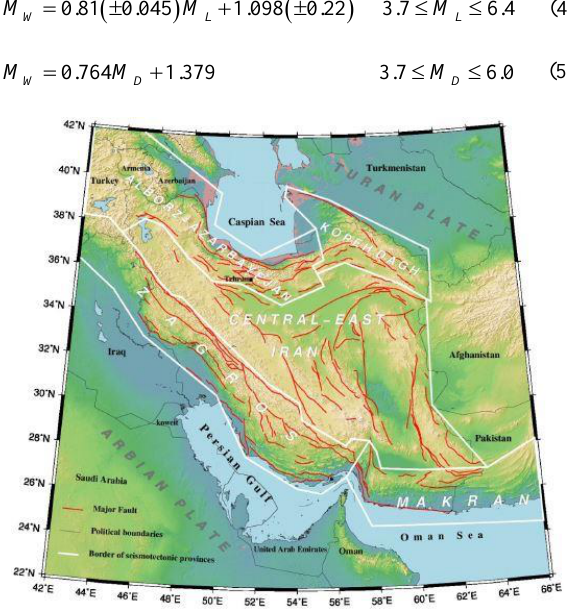
Figure 1. Major tectonic provinces of Iran developed by Mirzaei et al (1998). The red lines depict the major active faults developed by Hessami et al (2003). Figure 2. Triangulation of the Zagros geodynamic network